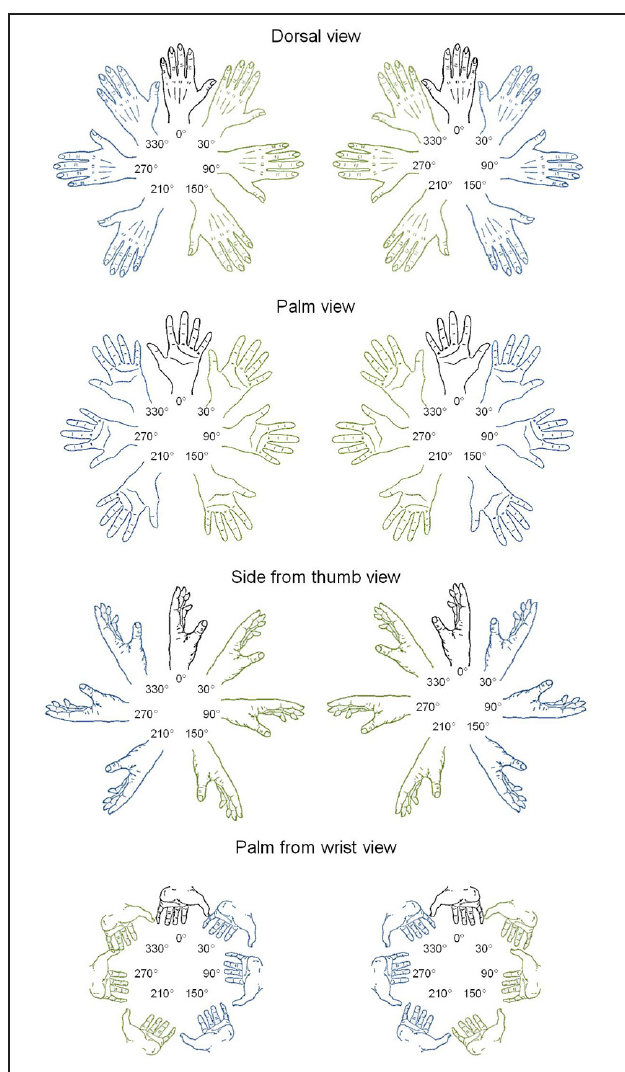
FIGURE 1 | Line drawings of left and right hands in four postures and seven rotation angles. In blue: lateral orientations; in green: medial